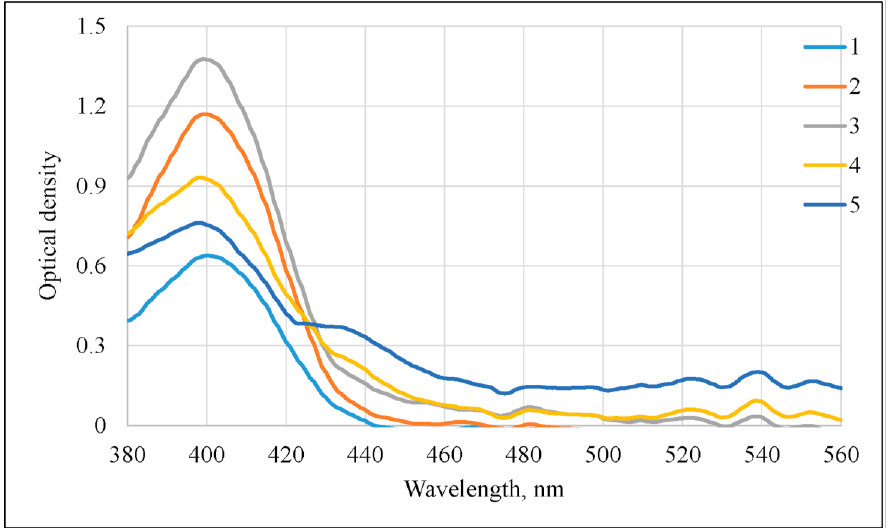
Figure 1. The absorption spectrum of samples obtained from yeast extract. The yeast extracts were obtained from samples of yeast S. cerevisiae 71B cultured in 20% glucose solution with the addition of: (1) sterile dH 2 O, (2) 0.5 mM AgNO 3 , (3) 1.0 mM AgNO 3 , (4) 1.5 mM AgNO 3 and (5) 2.0 mM AgNO 3.